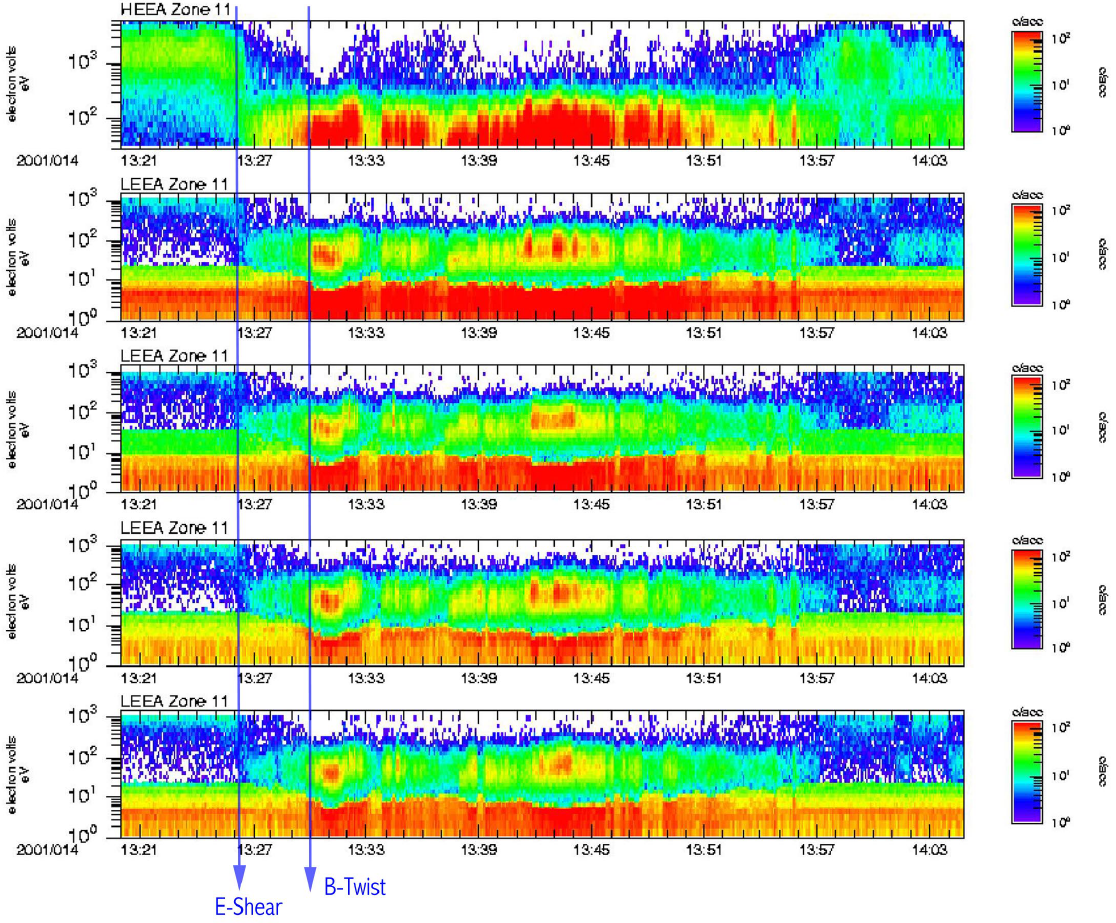
Fig. 21. PEACE data of electron fluxes versus energy and time from the high energy electron detector (HEEA) on one spacecraft and the low energy detectors (LEEA) on all 4spacecraft from 13:20 to 14:05 UT. The two key events identified in the electric and magnetic field data in Fig. 20 are marked with vertical arrows and